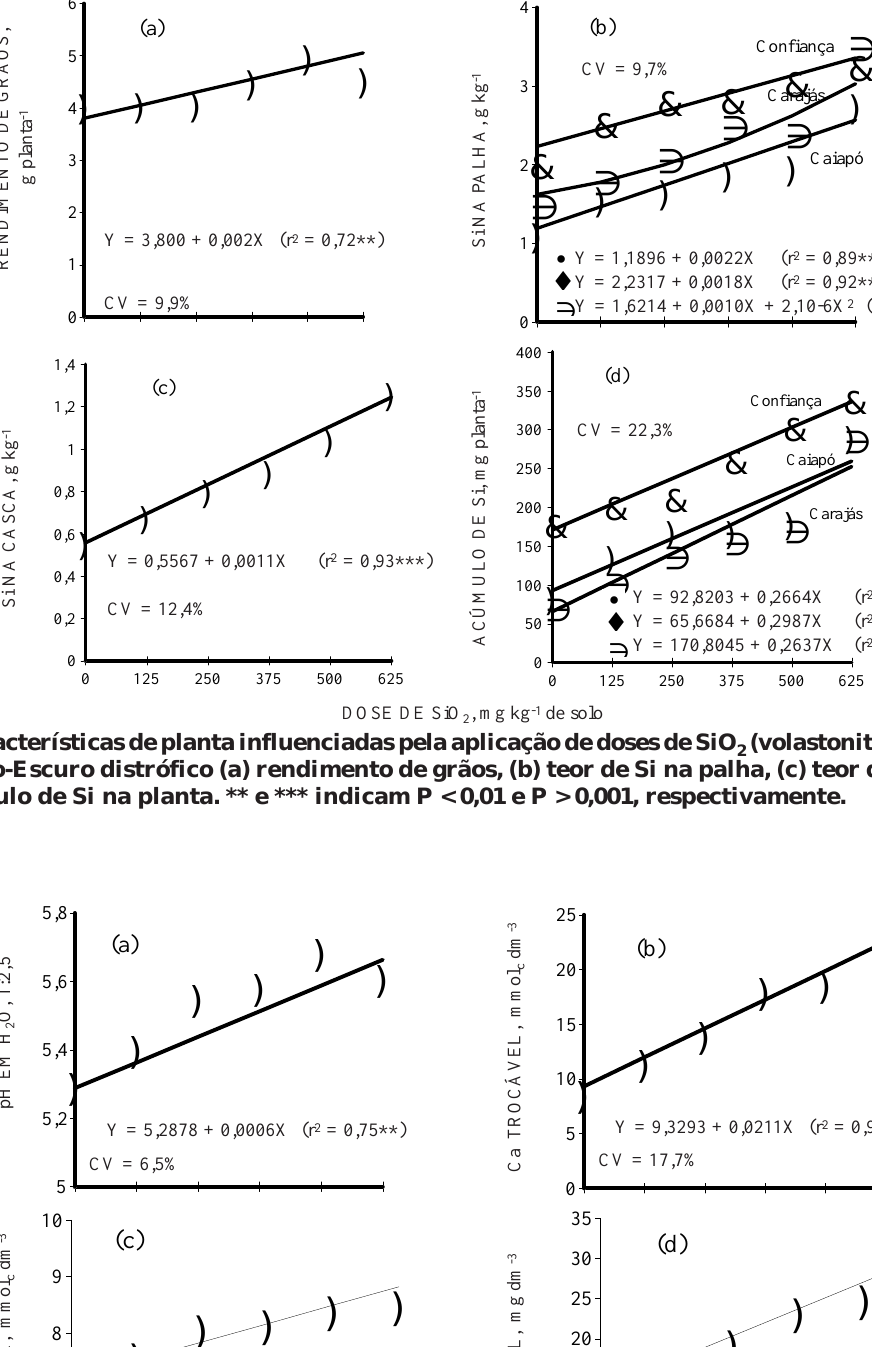
(volastonita) em Latossolo 2